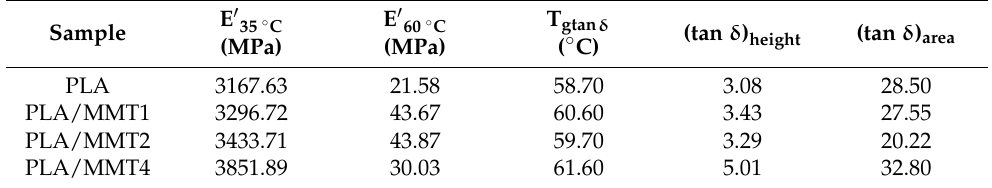
Figure 11. DMA plots of ( a ) Storage Modulus E’, ( b ) Loss Modulus E’’ and ( c ) loss factor tan δ as a function of temperature for the 3D-printed specimens of PLA/MMT. Table 9. DMA analysis results, including Dynamic modulus (E (cid:48) ), glass transition temperature (T g ), and loss tangent (tan δ ) of PLA and PLA/MMT 3D-printed